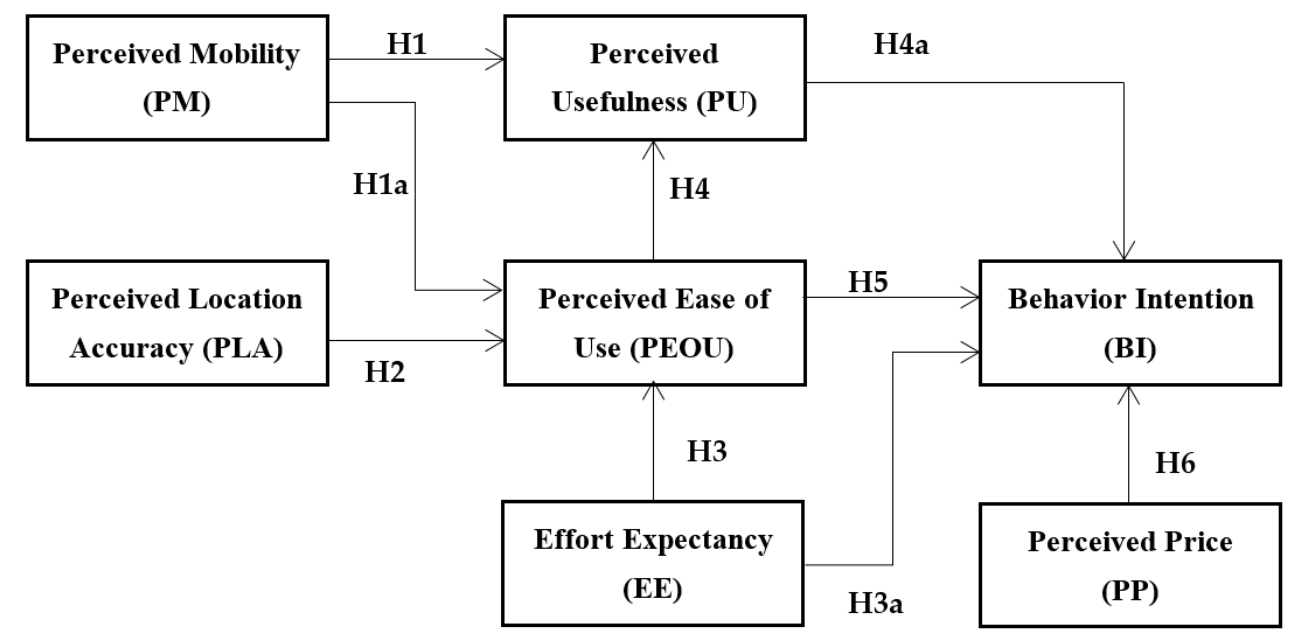
Figure 1. Proposed Research Model.